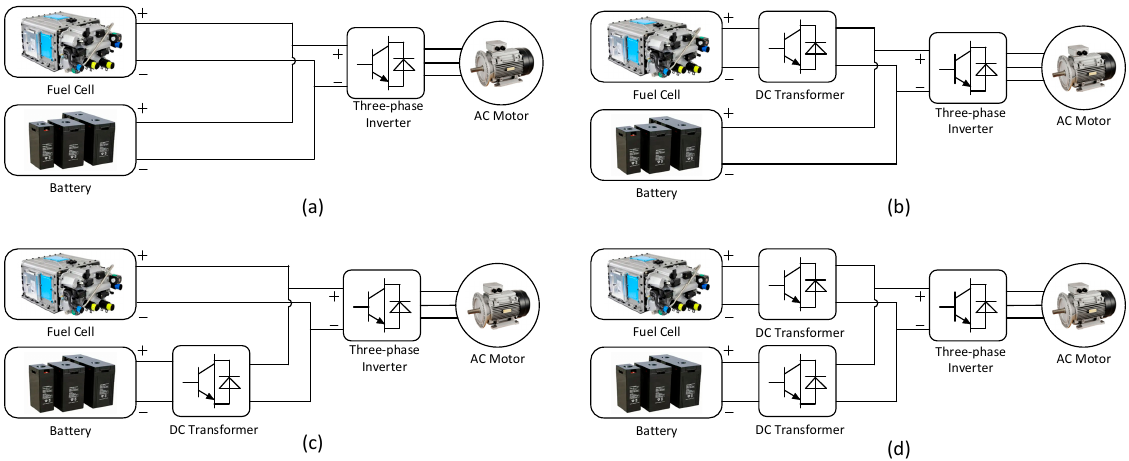
Figure 3. Topology of an FCEV (FC+B): ( a ) Passive topology; ( b ) Semi-active topology; ( c ) Semi-active topology; ( d ) active topology. The fuel cell is connected to the DC bus through a DC transformer. The circuit structure of a typical DC transformer is shown in Figure 4. This unidirectional DC/DC transformer can boost the output voltage of the fuel cell and maintain the DC bus voltage.